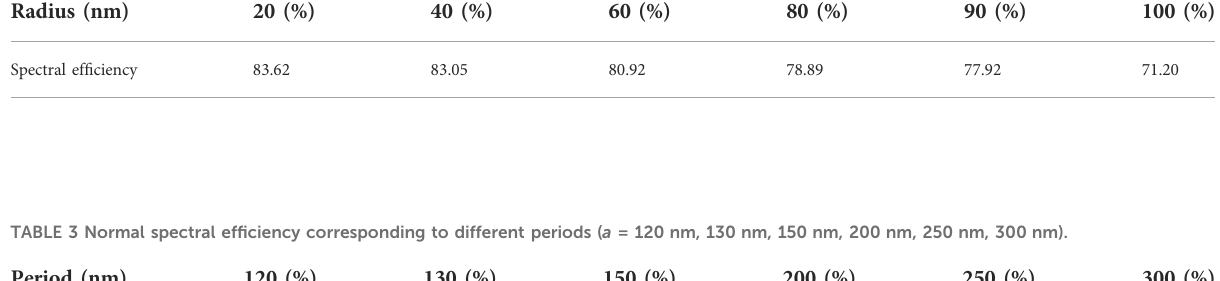
TABLE 2 Normal spectral ef fi ciency corresponding to different radii ( r = 20 nm, 40 nm, 60 nm, 80 nm, 90 nm and 100 nm). Radius